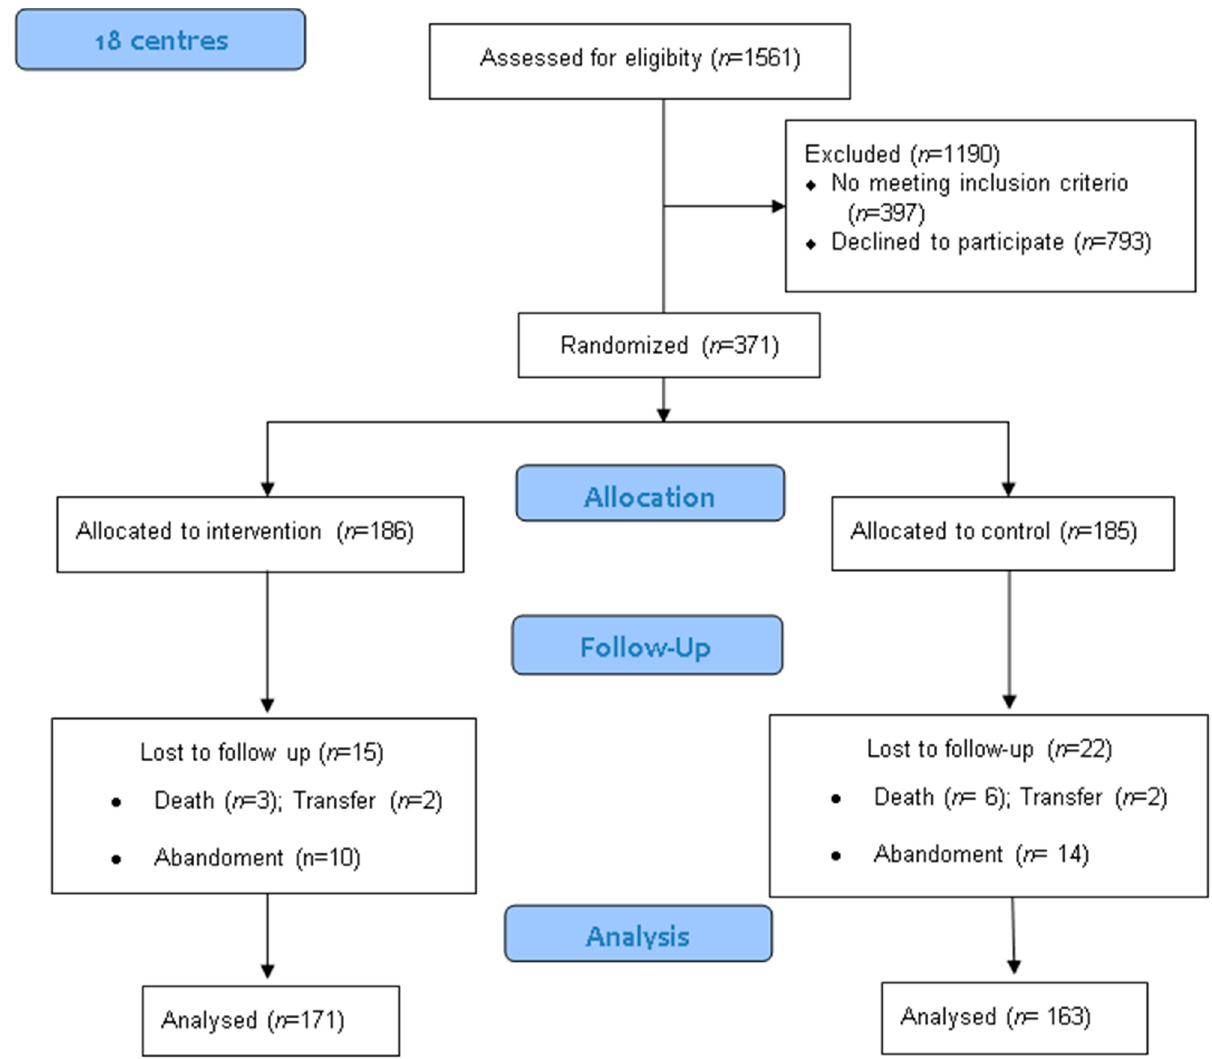
Figure 1. Participant flow chart.